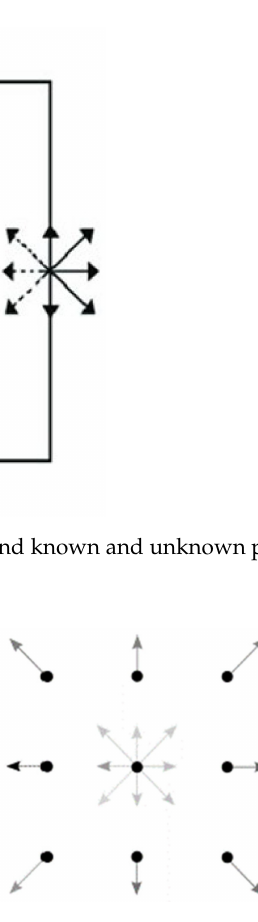
Figure 2. Propagation step in a D 2 Q 9 square boundary lattice Boltzmann model geometry.